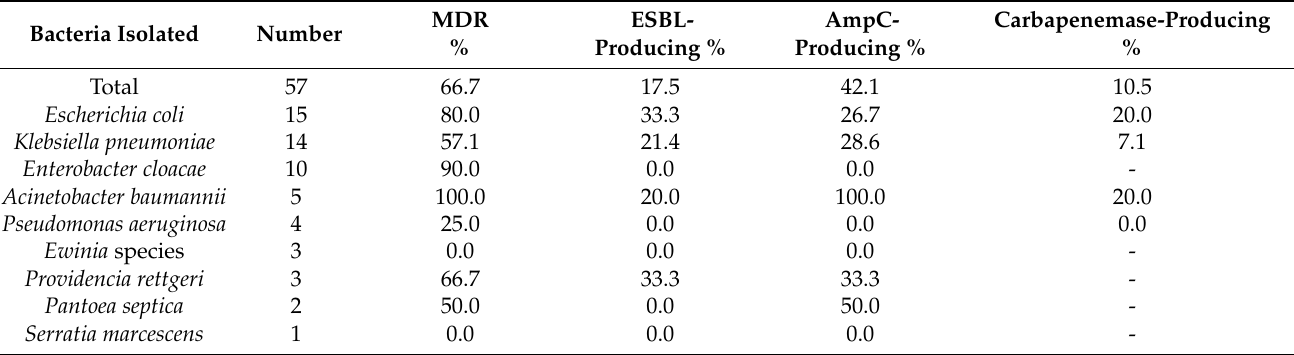
Table 3. Percentages of MDR and ESBL-, AmpC-, and carbapenemase-producing bacteria isolated from the nasopharynx of healthy under-five children in Accra, Ghana, from September to Decem- ber